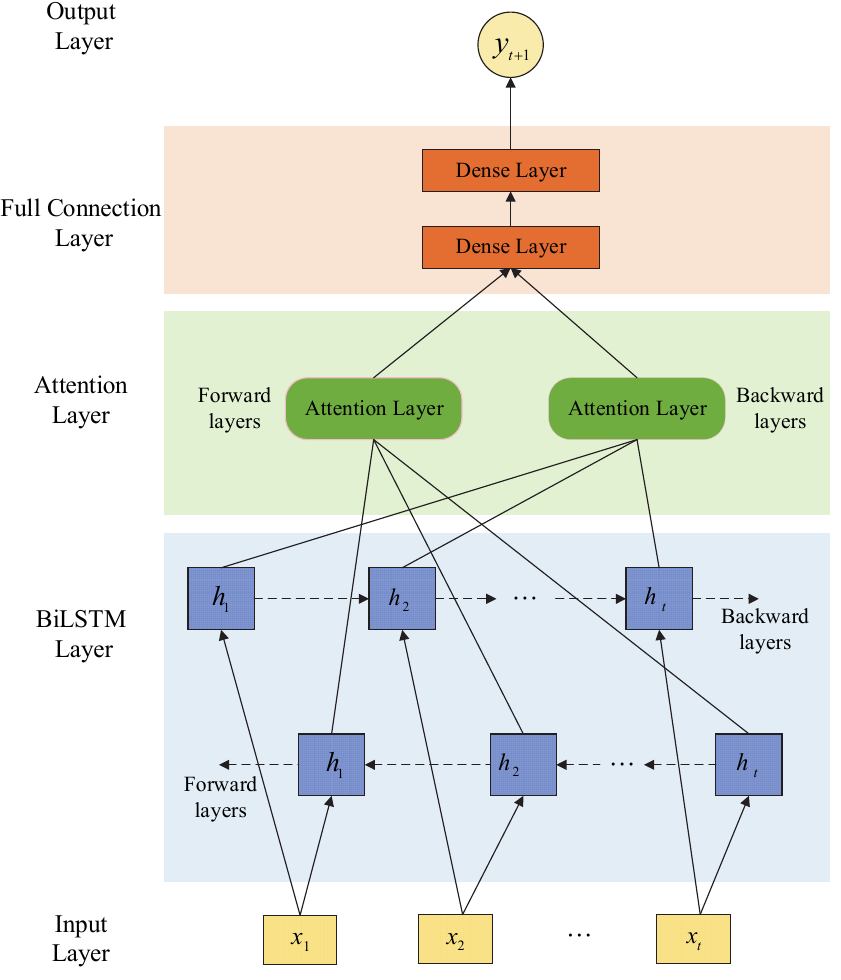
Figure 5. Framework of the proposed model.